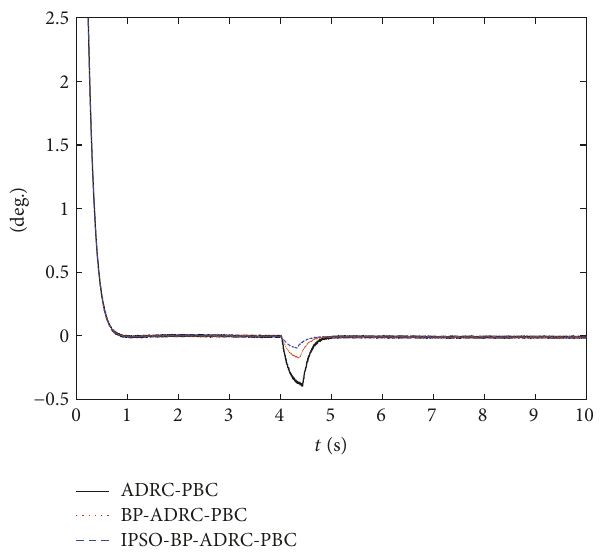
Figure 13: Positioning error with external loading